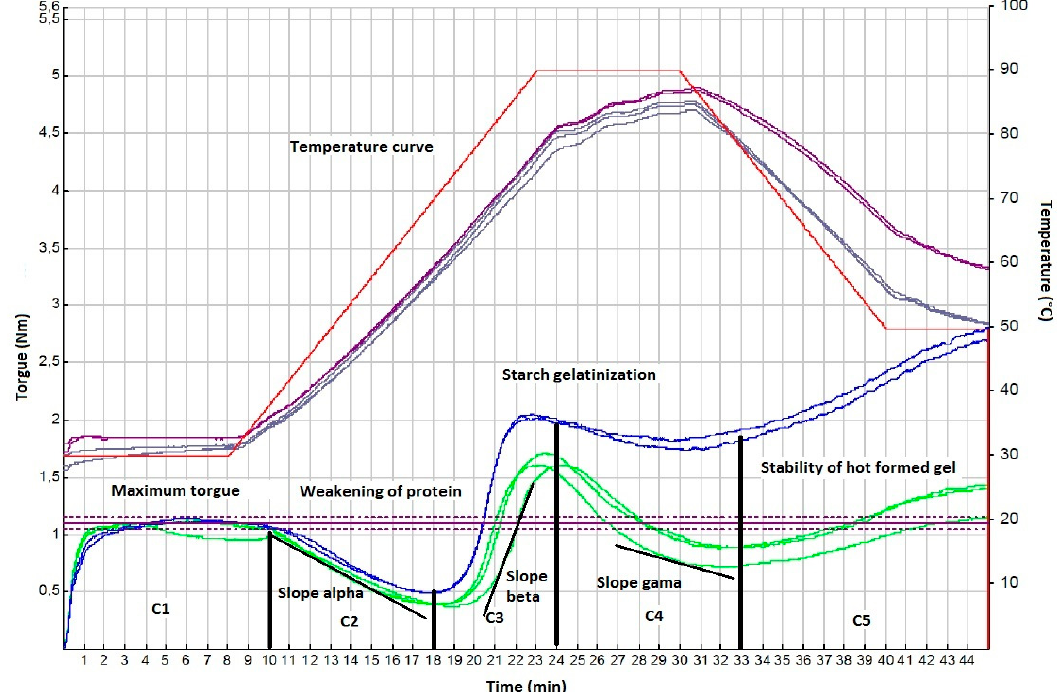
Figure 1. The Mixolab curves from wheat flour. Time for C1: The time evolution of the dough. The stronger the flour, the longer the time evolution (time to reach C1); Amplitude: The elasticity of the dough. The higher the value, the more flexible the flour; Stability: Resistance against kneaded dough. The longer the duration, the stronger the flour; C2: Attenuation of protein due to mechanical work and temperature; C3: The gelling starch; C4: The stability of the hot gel; C5: Measured starch retrogradation in the cooling phase; Guideline α (C1–C2): Attenuation rate of protein in warming; Guideline β (C3–C4): Speed starch gelatinization; Guideline γ (C5–C4): The rate of enzymatic degradation. [16].